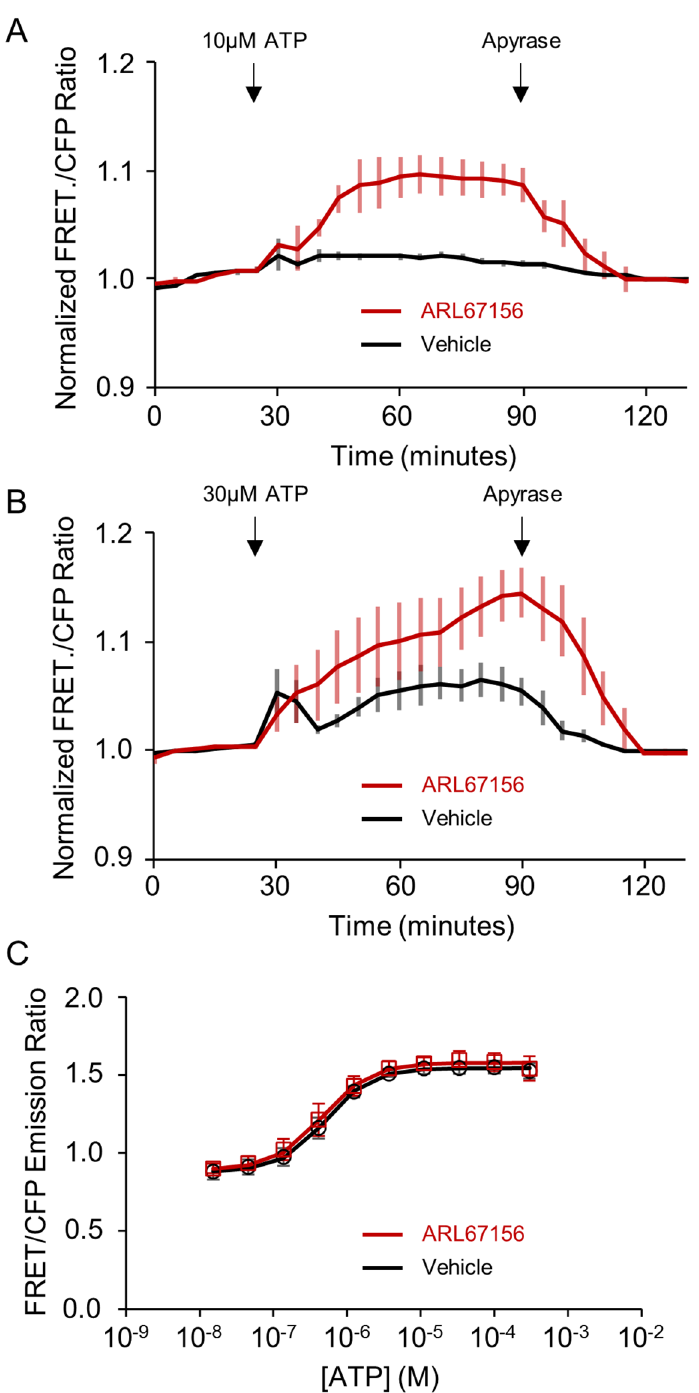
Fig 4. ecATeam3.10 detects ATP hydrolysis by ectonucleotidases. Live Neuro2Acells expressing ecAT3.10 were imaged under non-perfusion, static bath conditions. (A) The additionof 10 μ M ATP did not elicit a response (black) unless the cells were pre-treatedwith the ectonucleotidase inhibitorARL67156 at 100 μ M (red). Apyrase additiondegradesextracellularATP confirminga reversible ATP-specific sensor response. (B) Ectonucleotidase inhibitionby ARL67156pre-treatment also potentiated responses when 30 μ M ATP was added. Vehicle, black. ARL67156, red. (A) and (B), n = 6, 2 independent investigators. (C) ARL67156 does not directly affect the ATeam3.10 sensor responseto ATP.